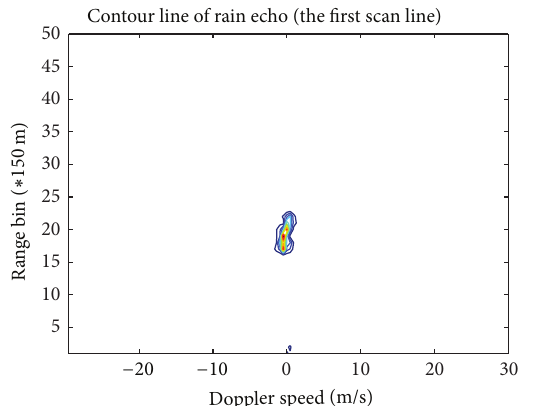
Figure 5: Rain Echo Spectrum Distribution of the first scan line (Contour Map).